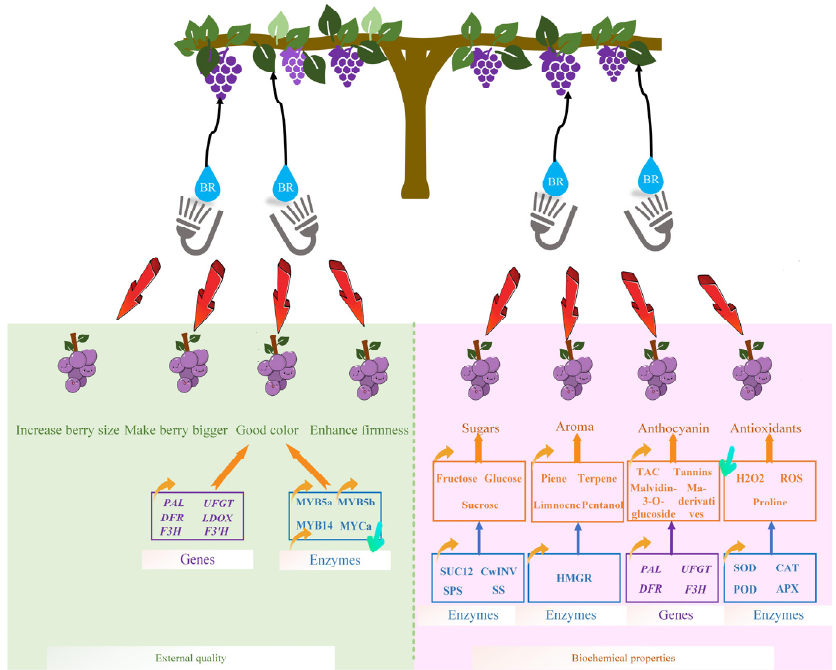
Figure 3. The effect of exogenous BR on the berry external quality improvement and biochemistry biochemical properties formation. External quality included berry size, berry color, and berry firmness. Biochemical properties include sugars (fructose, glucose, and sucrose), aroma substances ( β -pinene, terpene, limonene, pentanol), anthocyanin (TAC, tannins, malvidin-3-O-glucoside, Ma-derivatives), and antioxidants (SOD, CAT, POD, APX). The mentioned enzymes and genes related to grape berry quality improvement are also listed in the figure.